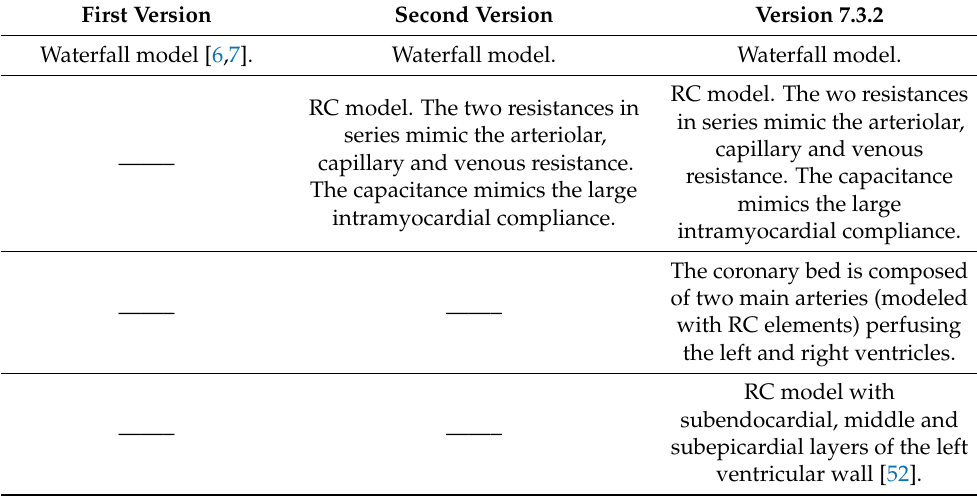
Table 3. Evolution over time of numerical models of the coronary